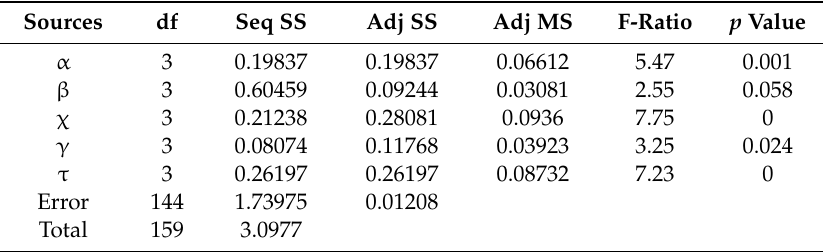
( a ) ( b ) Figure 5. Convergence analysis for different instances when ρ = 10. ( a ) The instance with 20 casts and 61charges; ( b ) The instance with 40 casts and 114 charges.